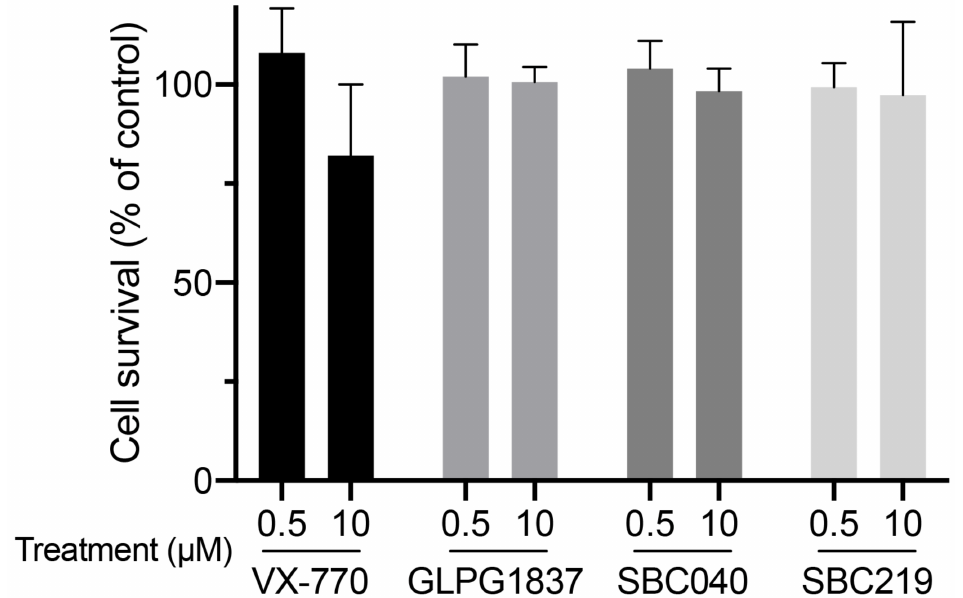
Figure 4. CFTR potentiators are not cytotoxic at 0.5 or 10 µ M. MDCK cells were treated with 0.5 or 10 µ M of the indicated potentiators for 2 h. Then, cytotoxicity was assessed using MTT assay and expressed as a percentage of the mean of the control (vehicle-treated cells). Means ( ± SEM) of at least three independent experiments (each performed in triplicate) per condition are